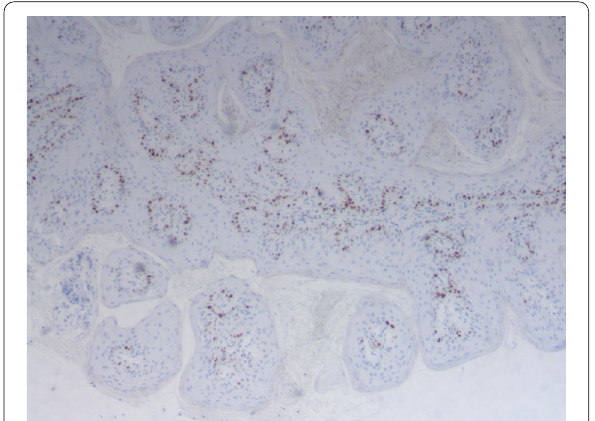
Fig. 3 Ki67 positive cells restricted to the basal layer